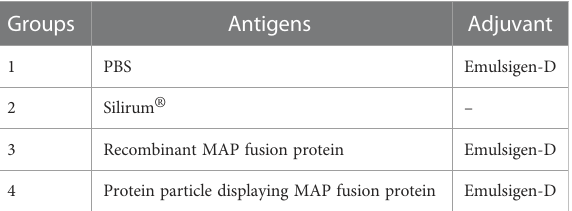
TABLE 2 Vaccine